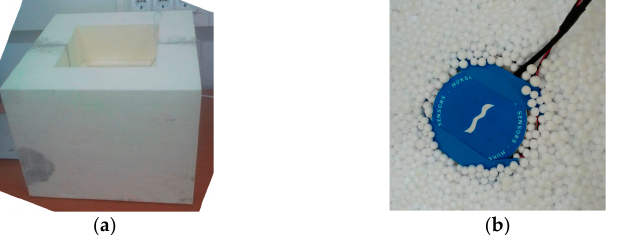
Figure 5. ( a ) External photography of the ambient hot-box and ( b ) detail of thermal flux sensor with EPSIn balls.